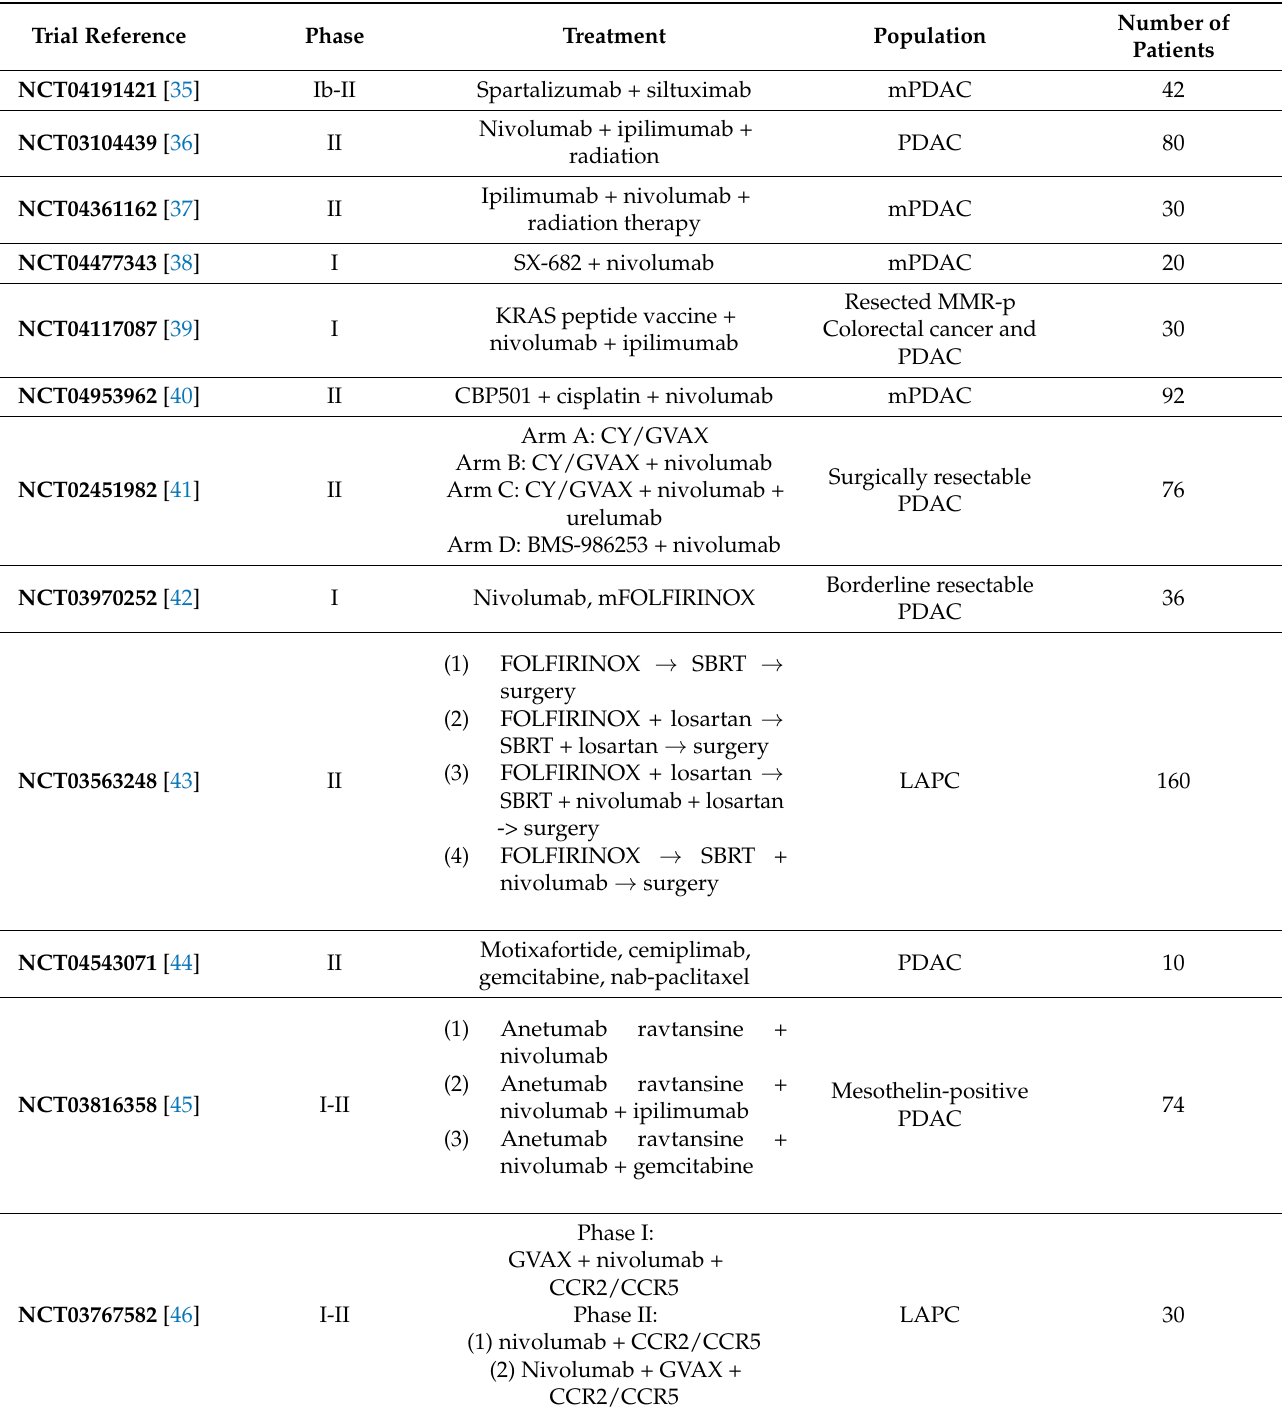
Table 2. Characteristics of ongoing trials with immune checkpoint inhibitors in